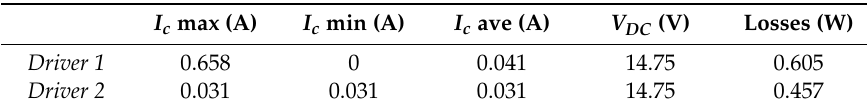
Table 3. Driver circuits